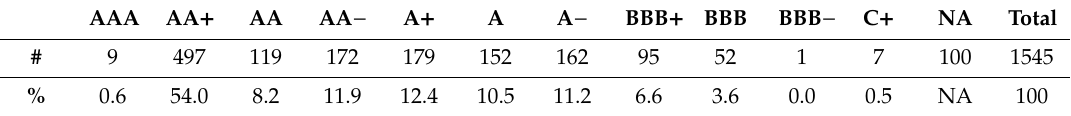
Table 2. Distribution of rated corporate bonds (CBs) in Japan Rating & Investment Information Center (R&I) categories (August 2010). NA, no rating.